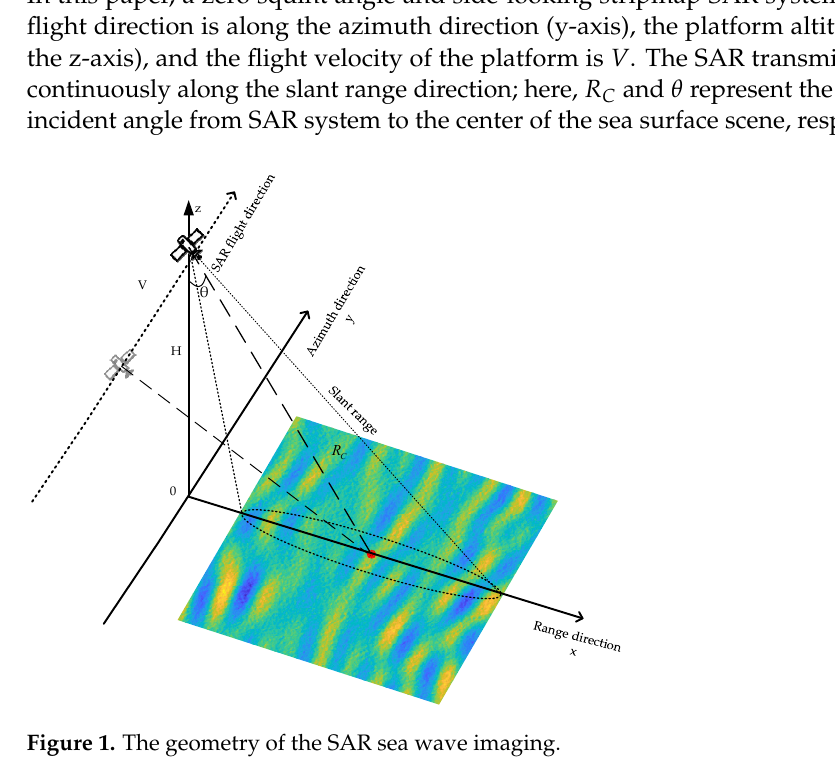
Figure 1. The geometry of the SAR sea wave imaging.